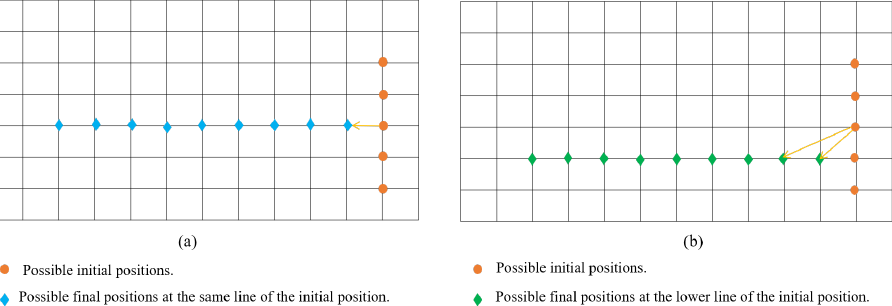
Figure 5. The initial and final positions at ( a ) Same line and ( b ) Different